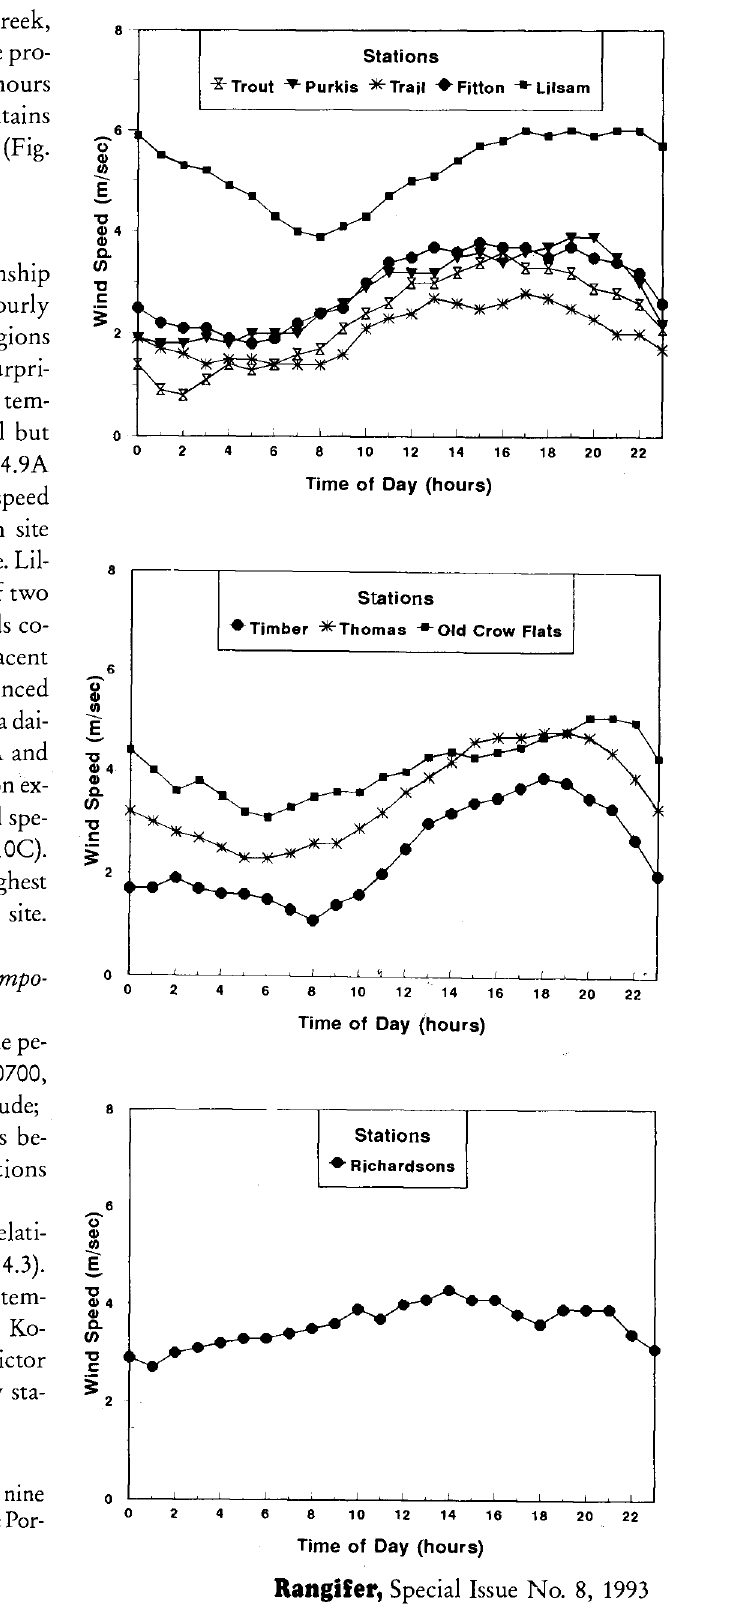
Figure 4.10. Average hourly windspeeds at nine sites on the summer range of the Por cupine Caribou Herd,